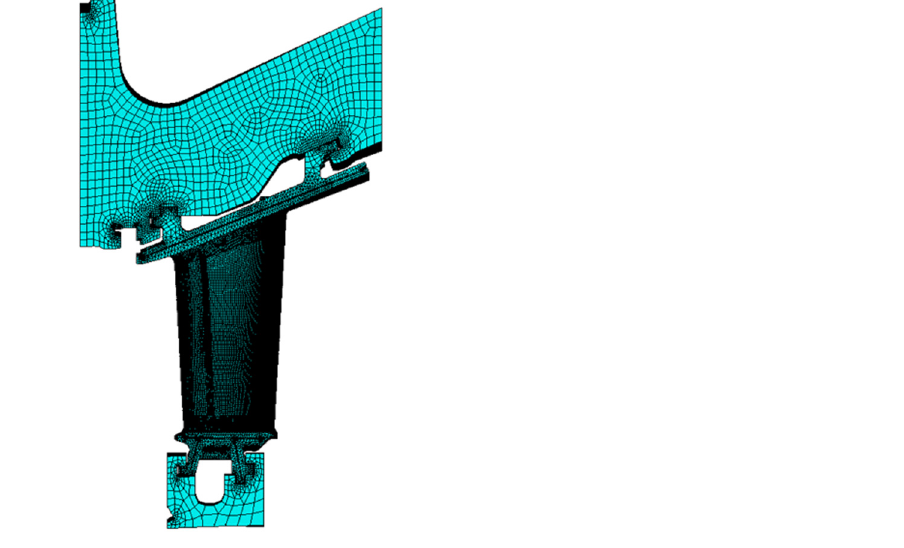
Figure 2. Finite element (FE) model of a turbine vane with its turbine cane carrier (TVC) and U-ring sector.